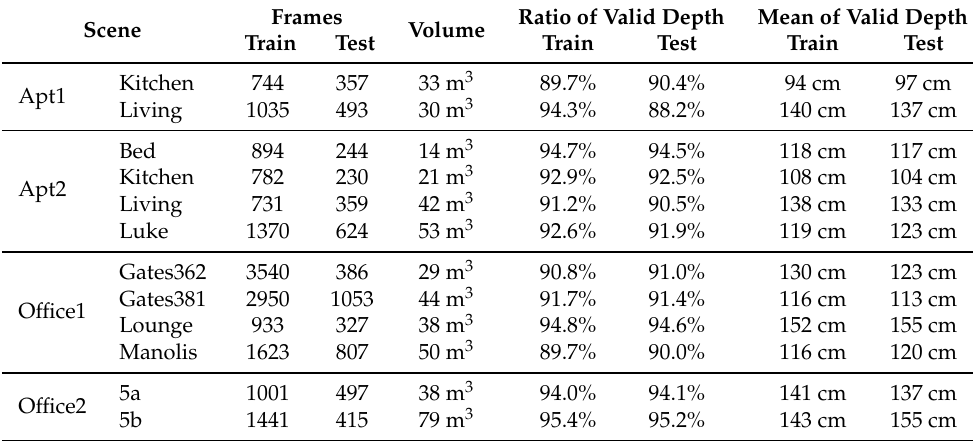
Table 2. Characteristics of 12 Scenes dataset.